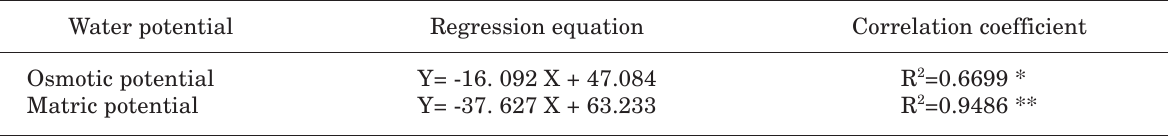
Table 2. Parameters of the regression equations relating the microsclerotium germination (Y) of Verticillium dahliae to the means of the osmotic and matric potential (X).